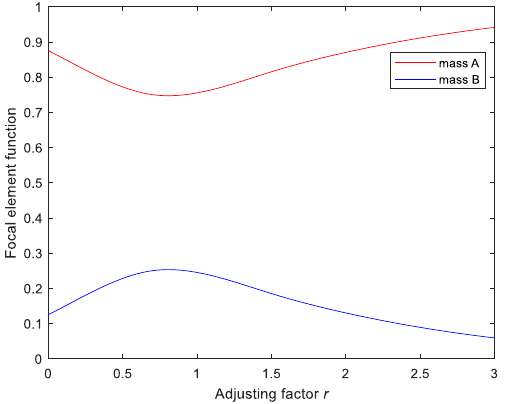
Figure 7. Focal element functions vary with the adjusting factor.